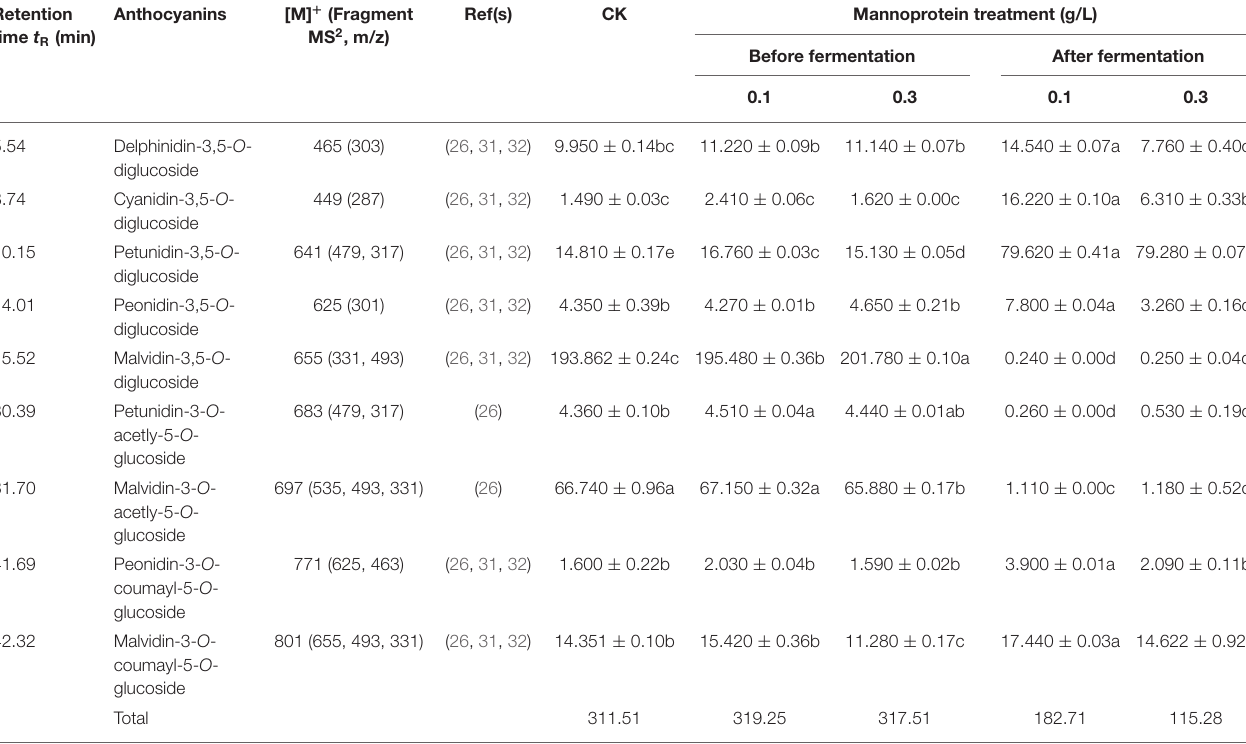
TABLE 2 | Effects of mannoprotein concentration on the anthocyanins profiles of wine at different stages of fermentation (mg/L). Retention Anthocyanins [M] + (Fragment Ref(s) CK Mannoprotein treatment (g/L) time t R (min) MS 2 , m/z) Before fermentation After